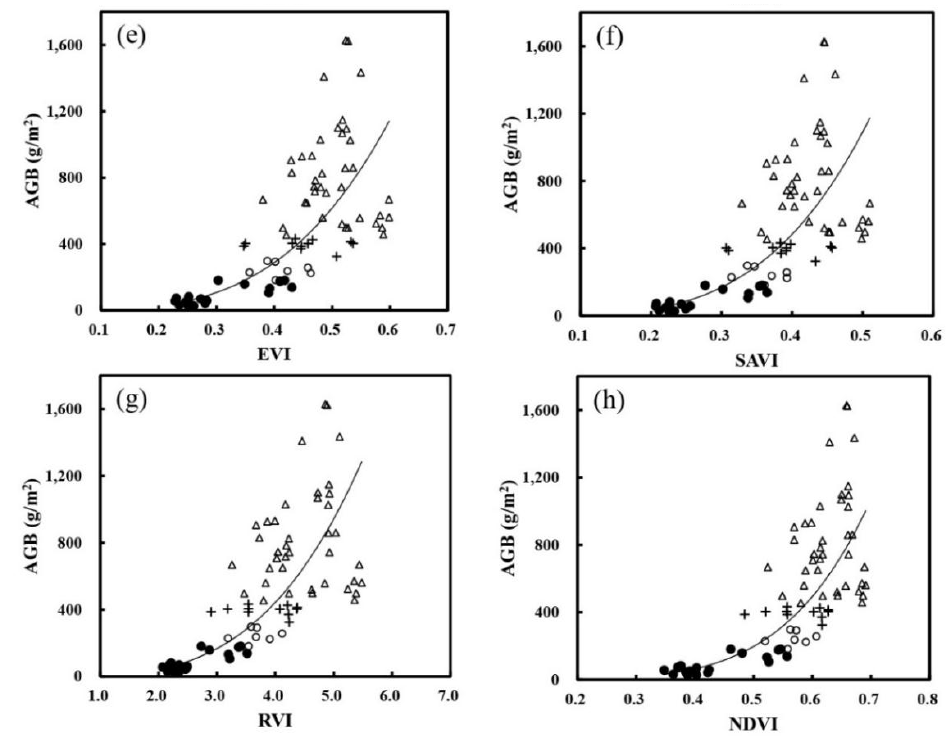
Figure 2. Scatter plots showing the relationships between the selected vegetation indices (VIs) and above ground biomass (AGB) of winter oilseed rape from October 2014 to May 2015 for ( a ) MTVI2; ( b ) EVI2; ( c ) OSAVI; ( d ) RDVI; ( e ) EVI; ( f ) SAVI; ( g ) RVI; and ( h ) NDVI; the data set used to establish the regression model is the calibration set; the power regression lines are also